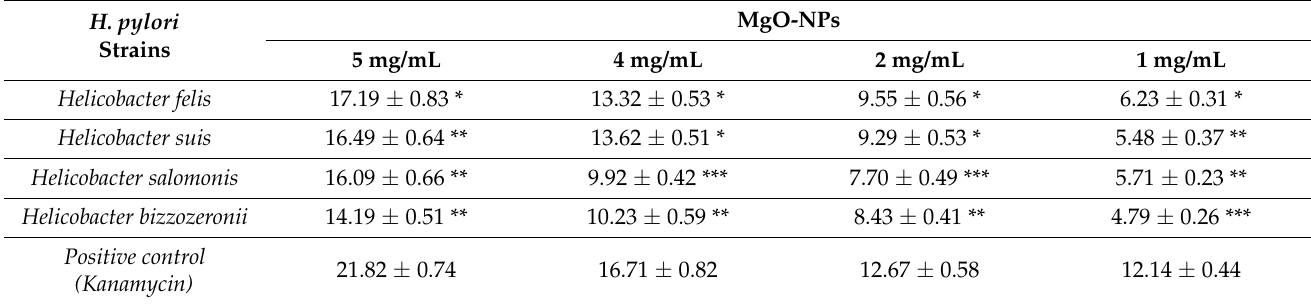
Table 1. Antibacterial potential of MgO-NPs against H. pylori isolates. H.